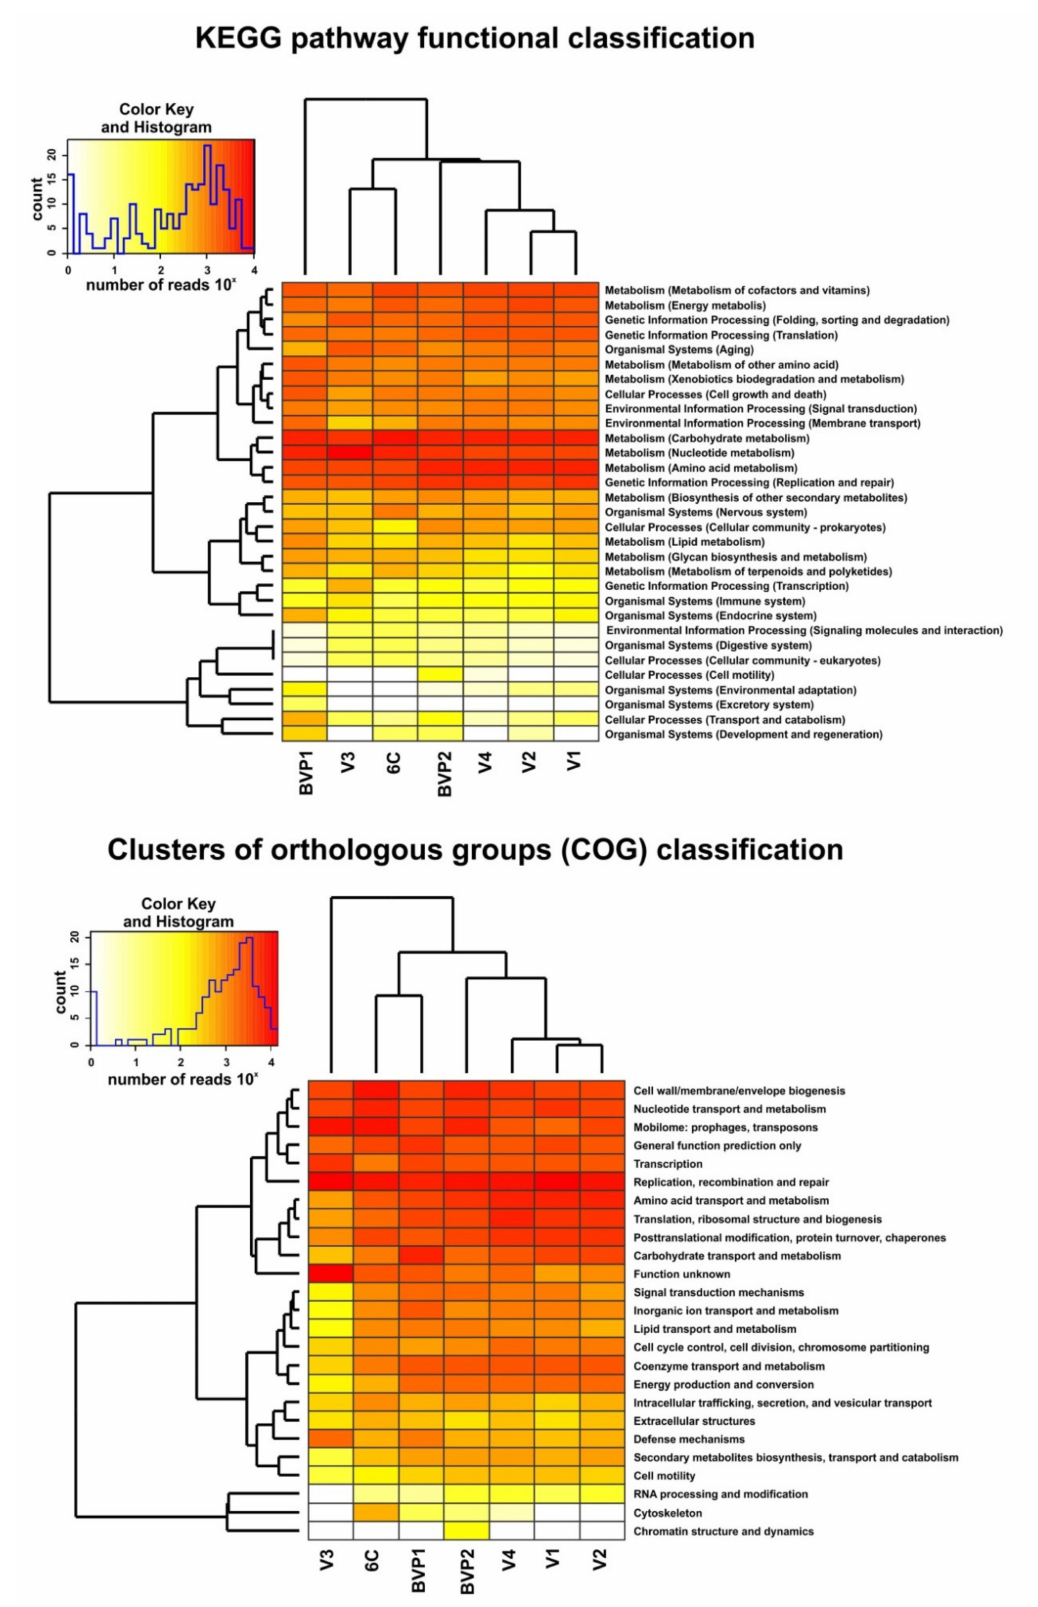
Figure 3. The main functional groups of the revealed genes according to the KEGG pathway and COG databases, and the clustering of the Baikal virome datasets based on functional analysis. Read counts of functional groups are shown in log10